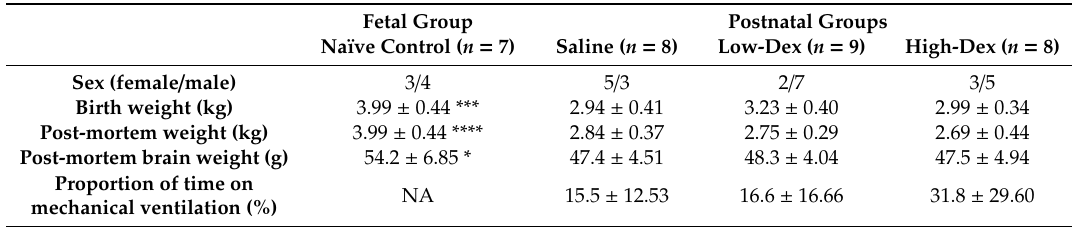
Table 1. Summary of preterm animal clinical data, and results of statistical tests.